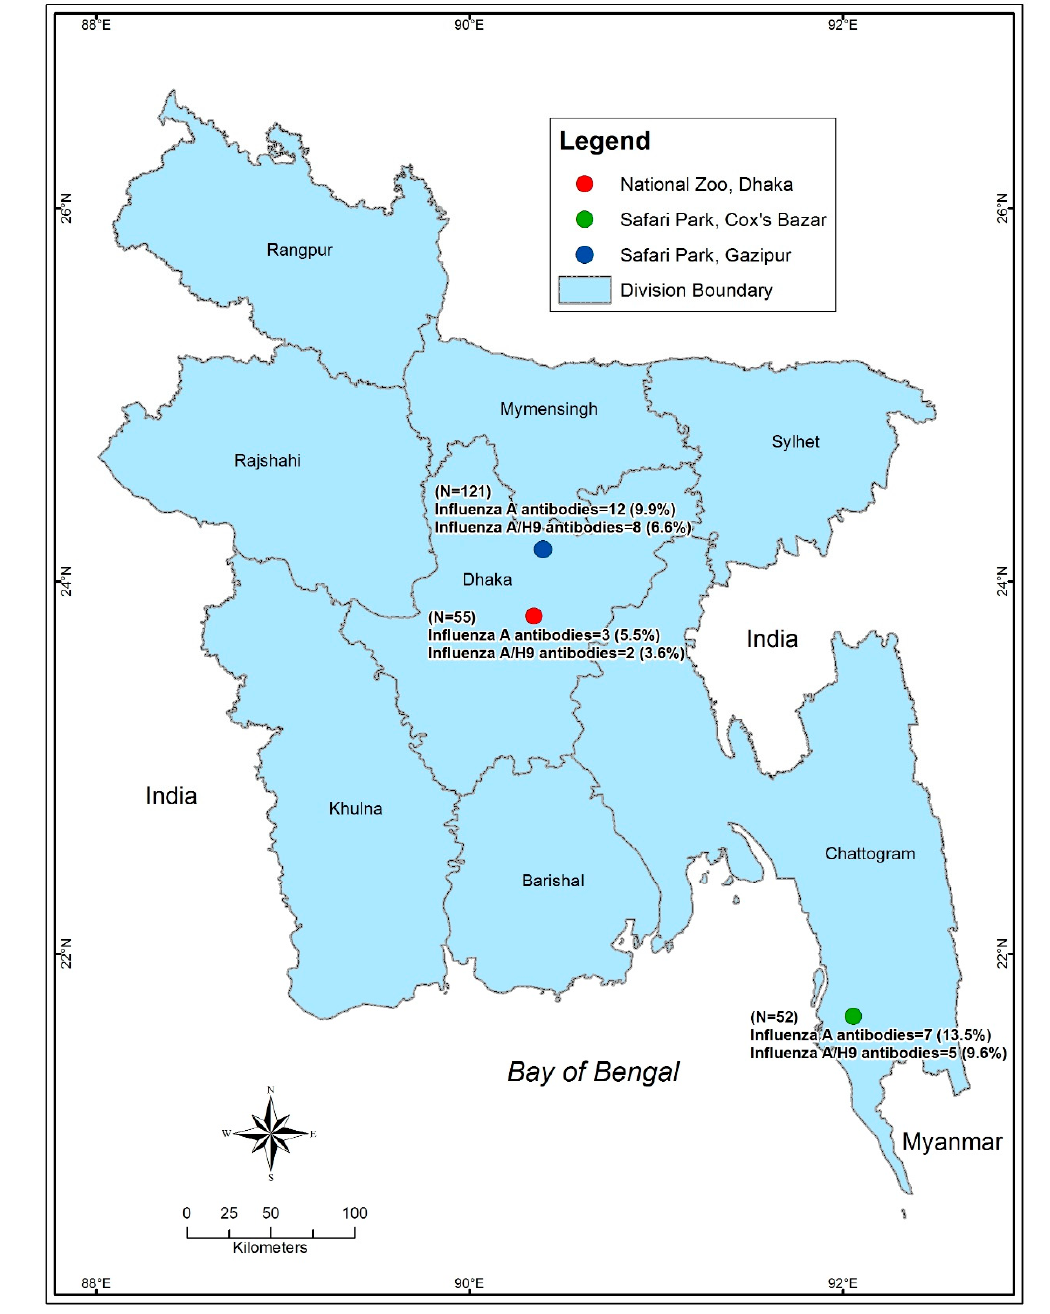
Figure 1. Map of Bangladesh showing the sampling locations. The map was plotted using the spatial analyst tool of ArcGIS (ArcMap, version 10.2, Environmental Systems Research Institute, Redlands, California, CA, USA). The three dots depict the sampling locations (Zoo and safari parks). The green dot depicts the Safari park of Cox’s Bazar, the red dot depicts the National zoo, Dhaka and the Blue dot depicts the Safari park at